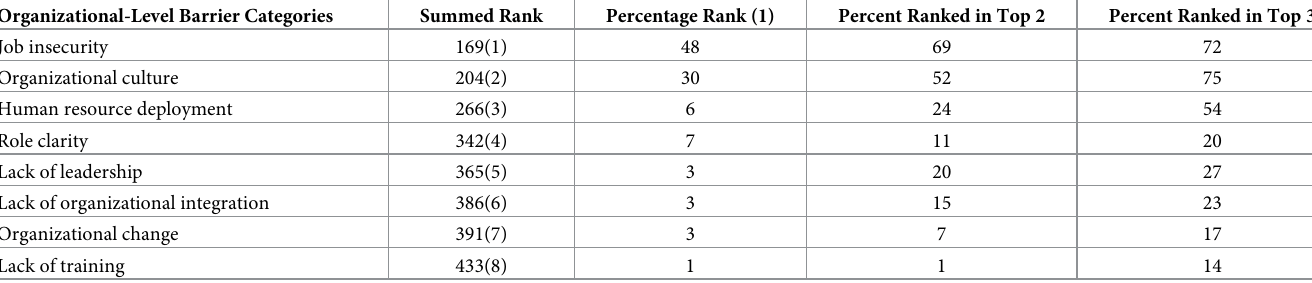
high targets and resource availability were ranked first and second, respectively (Table 8: summed ranks = 206 and 229, respectively). House job requirement and dual practice were ranked as third and fourth, and remained significantly different from each other (summed Table 6. Rank orders(organizational